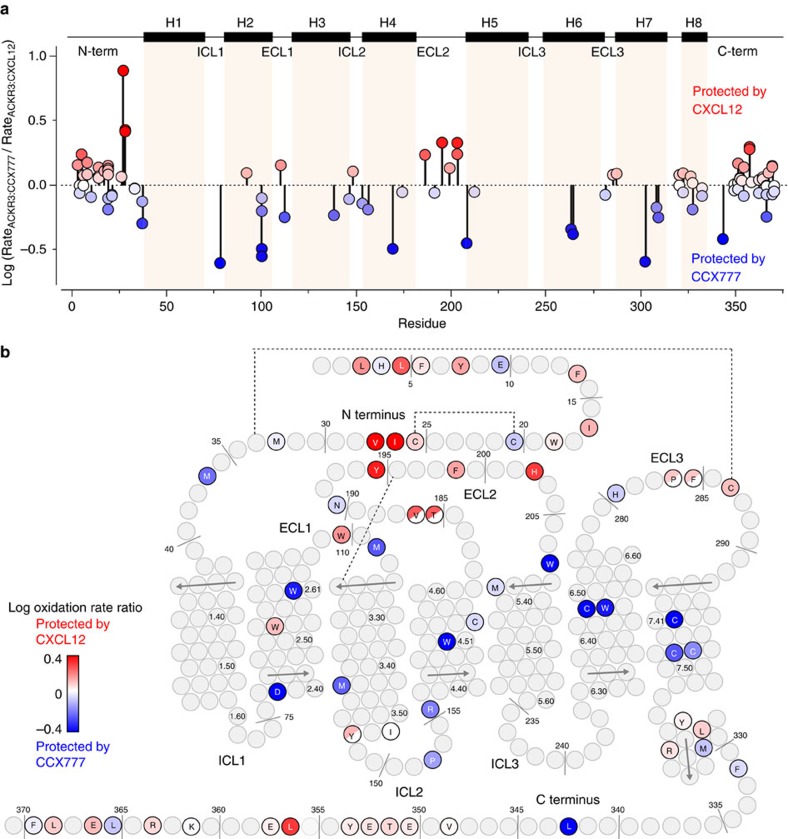
Radiolytic footprinting of ACKR3 complexes.(a) All detectable ACKR3 oxidation rates mapped onto the sequence. Rates are shown as the log of RateACKR3:CCX777/RateACKR3:CXCL12. Residues are coloured using a gradient where blue corresponds to reduced oxidation rates in the ACKR3:CCX777 complex (protection by CCX777) and red corresponds to reduced oxidation rates in the ACKR3:CXCL12 complex. (b) Radiolytic footprinting results mapped onto a topology plot of ACKR3. Residues for which oxidation rates were measured are highlighted and coloured according to the scheme in (a). Residues where multiple rates were measured are coloured by the average log (RateACKR3:CCX777/RateACKR3:CXCL12 ) of the multiple oxidation events. Half-coloured circles signify that an oxidation rate was mapped to one or both of two neighbouring residues.